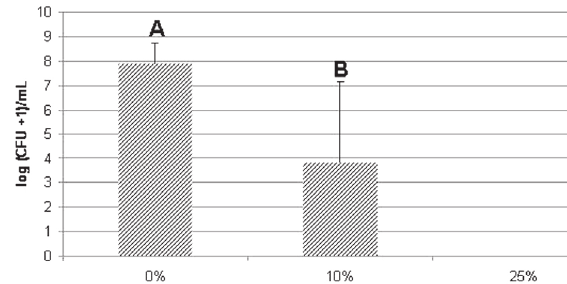
Figure 1- Effect of different percentages of poly(2-tert- butylaminoethyl) methacrylate (PTBAEMA) incorporated into acrylic resin specimens on the viability of Staphylococcus aureus biofilm cells. Error bars represent standard deviations ( α =0.05). Different capital letters denote significant differences among groups (Mann- Whitney test, p